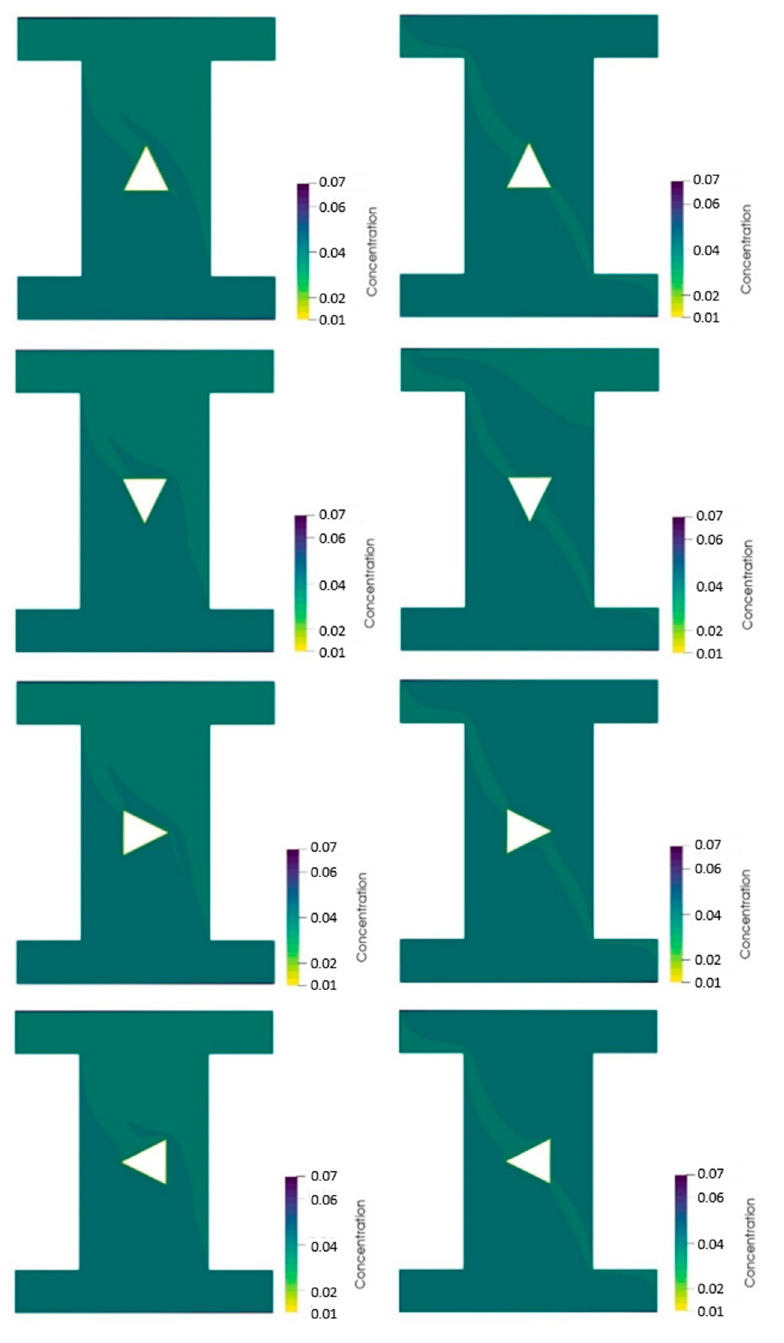
Figure 8. NP distribution contours of the 4% vol. NF in two different cavities including the sand-based ( left column ) and the metallic powder-based ( right column ) porous cavities with different orientations of the hot block .